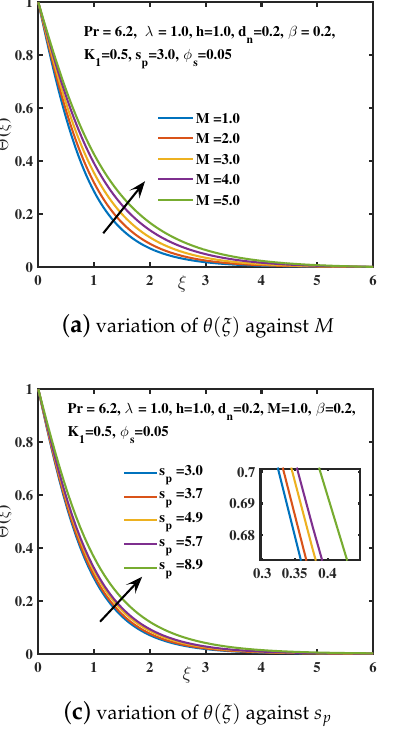
Figure 10. The effect of Magnetic parameter M , nanoparticle diameter d n , and shape factor s p on temperature